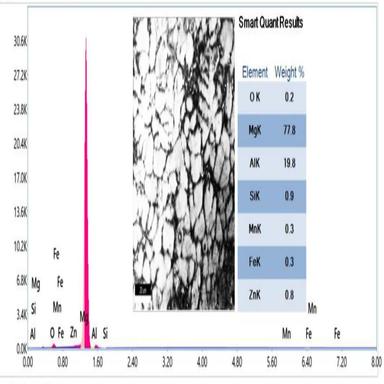
EDX Analysis (a) AZ31 alloy, b) AZ31-1.0 B4C, C) AZ31-2.0 B4C.